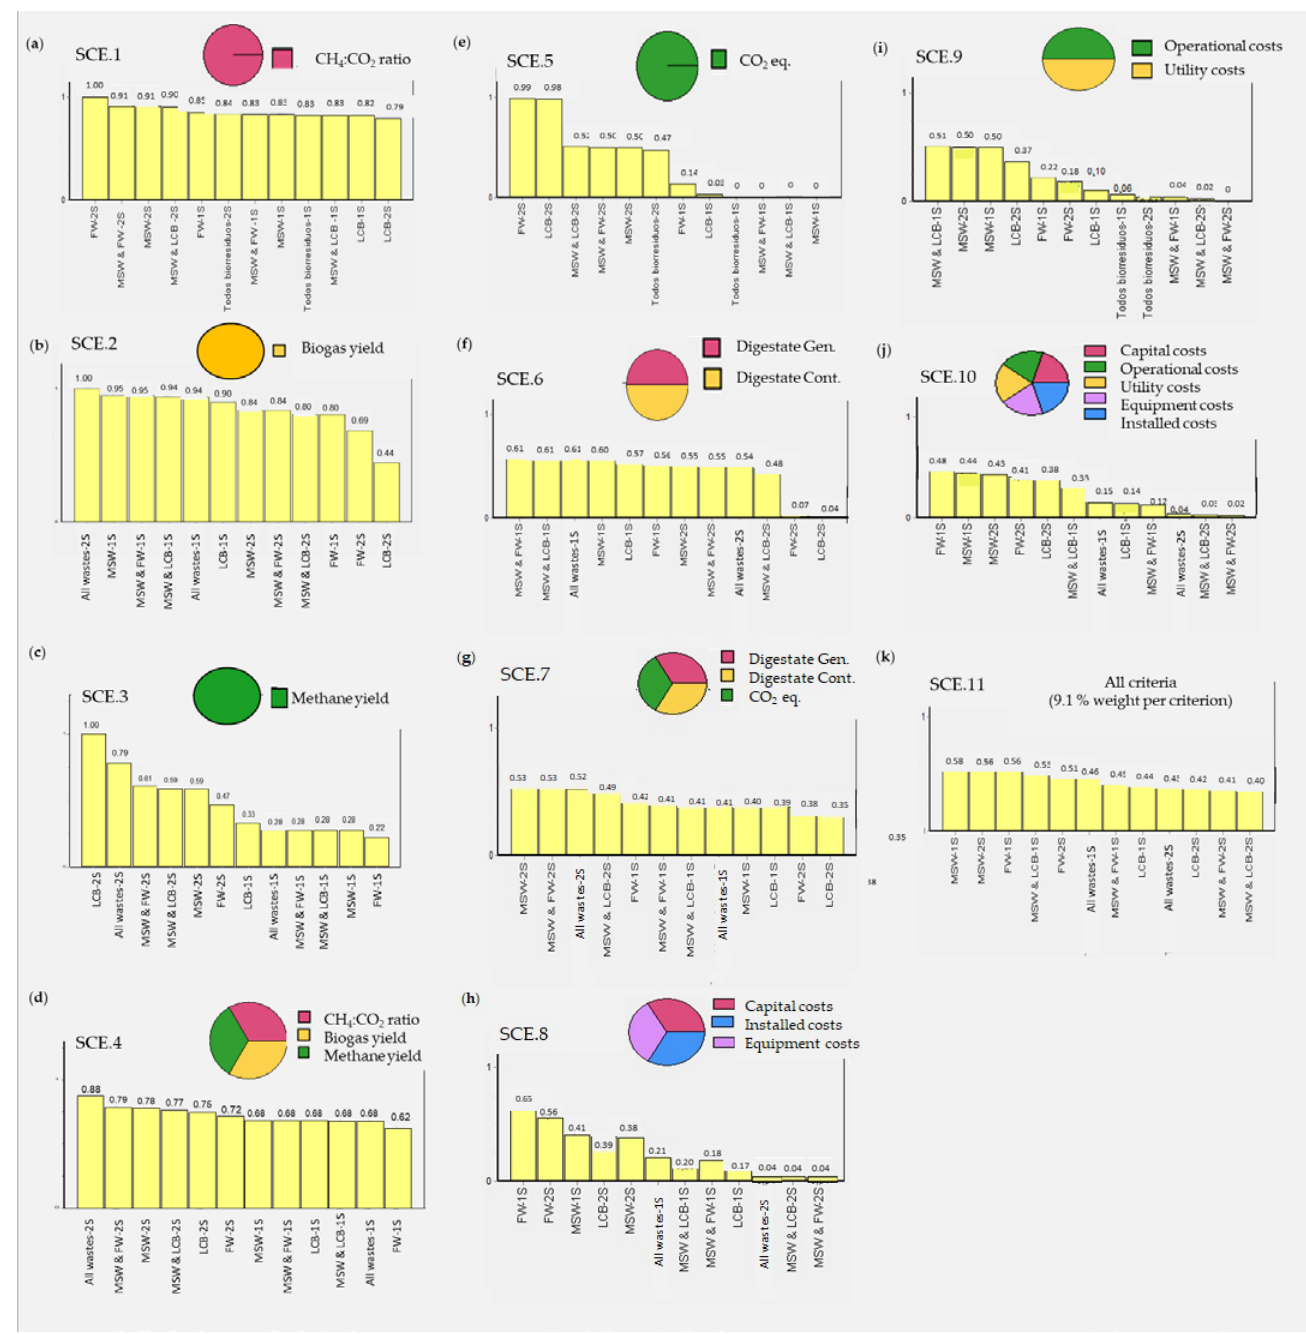
Figure 3. MCA-WS ranking results for the biogas plant alternatives under the formulated scenarios: ( a ) SCE.1; ( b ) SCE.2; ( c ) SCE.3; ( d ) SCE.4; ( e ) SCE.5; ( f ) SCE.6; ( g ) SCE.7; ( h ) SCE.8; ( i ) SCE.9; ( j ) SCE.10; ( k ) SCE.11.